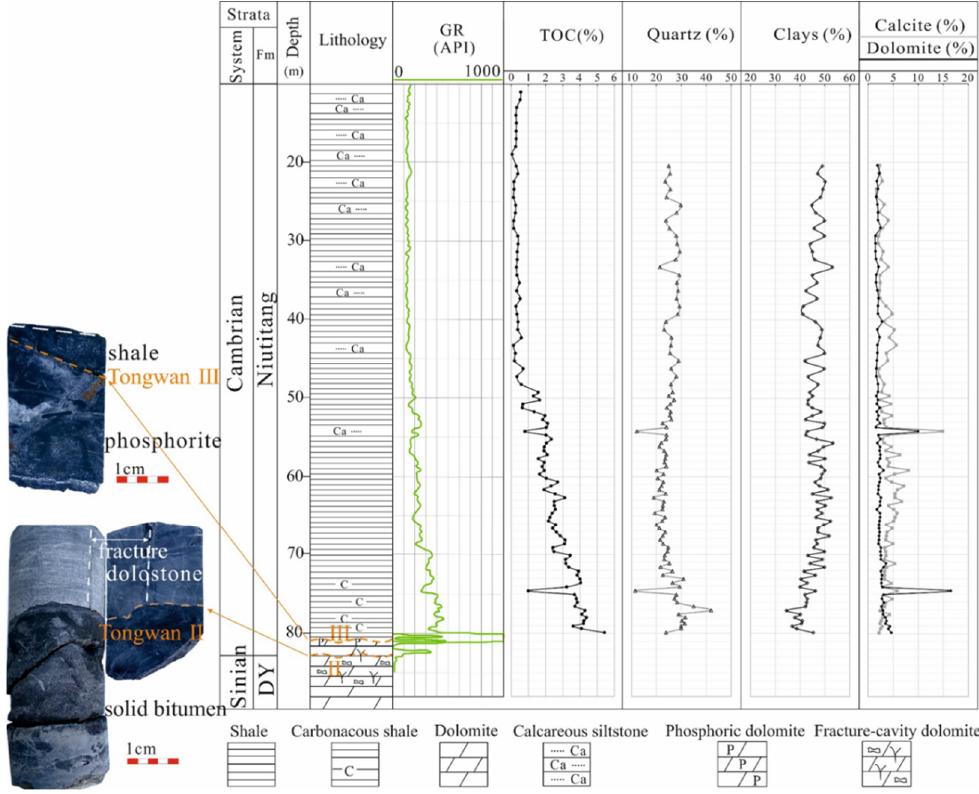
Figure 3. Depth profiles of gamma-ray (GR), total organic carbon content (TOC), quartz, clay, and carbonate contents for the Niutitang shale in Jindingshan-1 (JDS-1) well, showing lithology, unconformities, and weathering karst dolostone. Carbonaceous shale here refers to shale with TOC content ≥ 3.0 wt.%. The orange lines represent the unconformity. II: The second episode of Tongwan movement; III: The third episode of Tongwan movement. DY = Dengying, Fm = Formation.